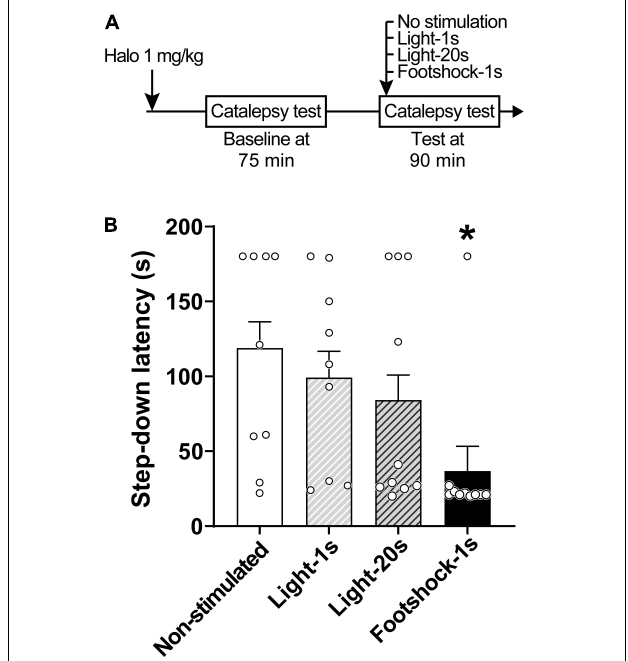
FIGURE 2 | Footshocks reduce step-down latency in the catalepsy test. (A) Timeline of the experimental procedure. (B) Step-down latency in groups of rats that received no stimulation (Non-stimulated), were stimulated with a 1-s light stimulus (Light-1 s), a 20-s light stimulus (Light-20 s), or a 1-s footshock (Footshock-1 s), 90 min after treatment with haloperidol 1 mg/kg. Marginal estimated means + S.E; circles represent individual animals. *Different from the Non-stimulated group. n = 9 for Non-stimulated and Light-1 s groups; n = 10 for Footshock-1 s and Light-20 s groups.